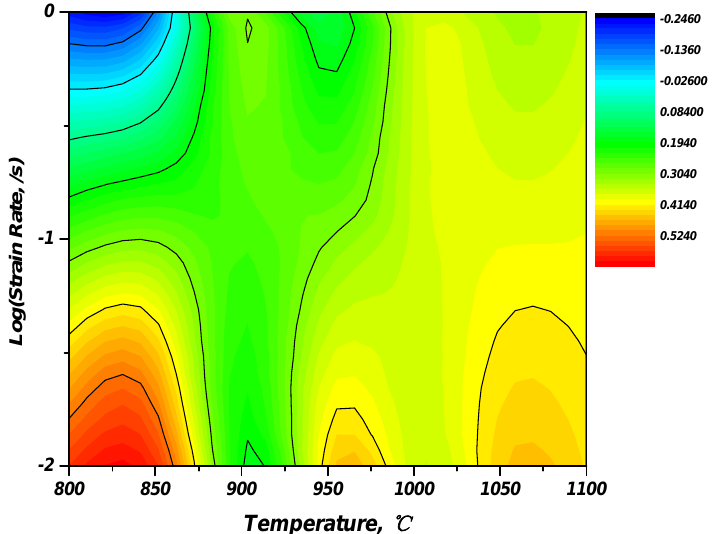
Figure 7. Deformation contour map shown by temperature-log(strain rate) relation of Ti-6Al-4V alloy ( ε = 0.6) indicating the efficiency of power dissipation.